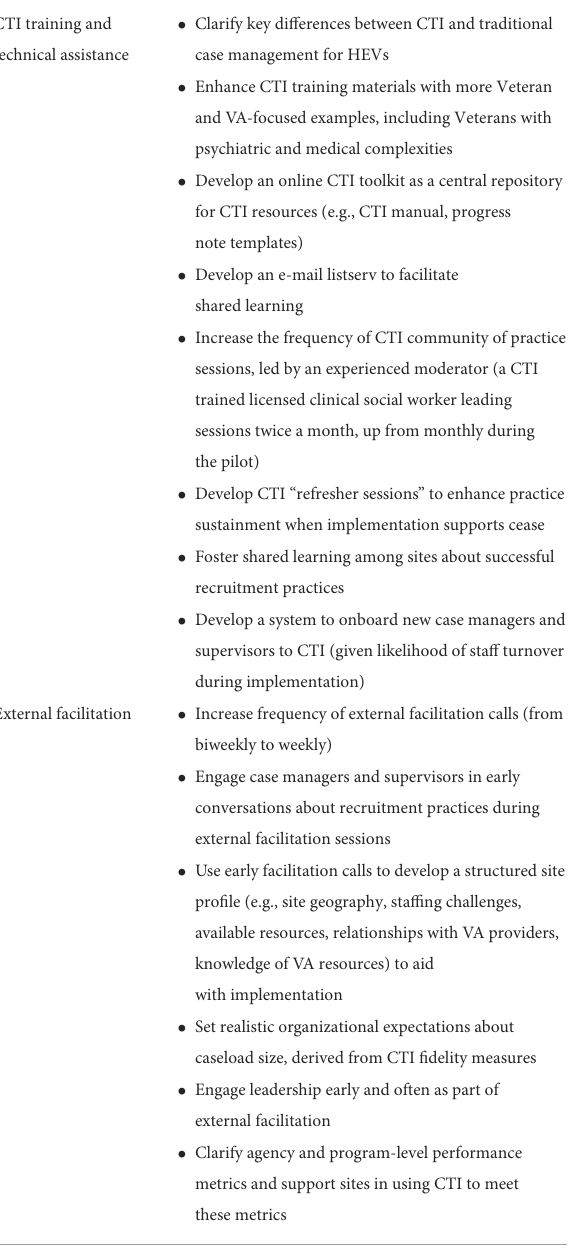
TABLE 4 Adaptations to CTI implementation package in preparation for national